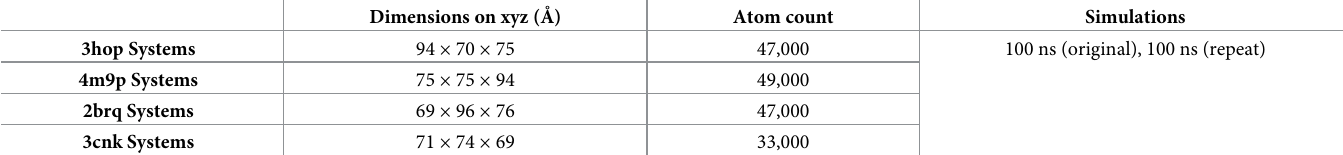
Table 2. Approximate dimensions and atom count of the systems prepared for molecular dynamics simulations, and simulation time